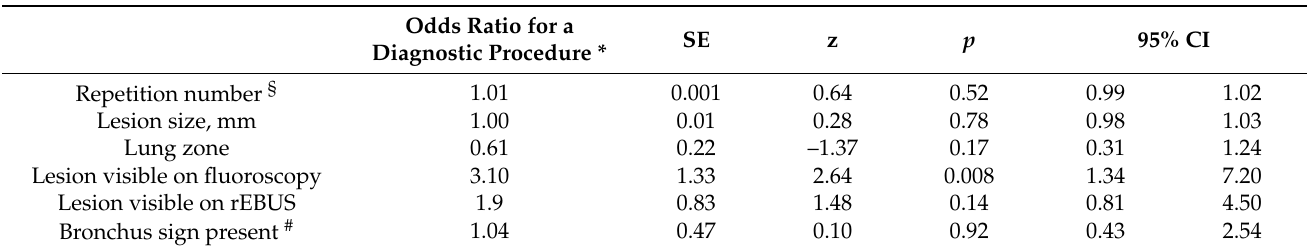
Table 3. Predictors associated with diagnostic yield (multivariate comparisons): Cross-classified random effects logistic